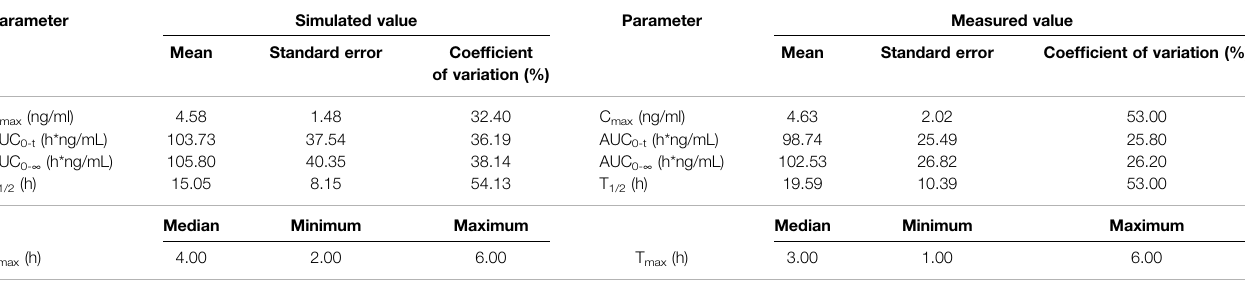
Median Minimum T max (h) C max , maximum concentration; AUC 0-t, area under the plasma concentration vs . time curve from the start of the last dose to the last time at which there is a quanti fi able concentration; AUC